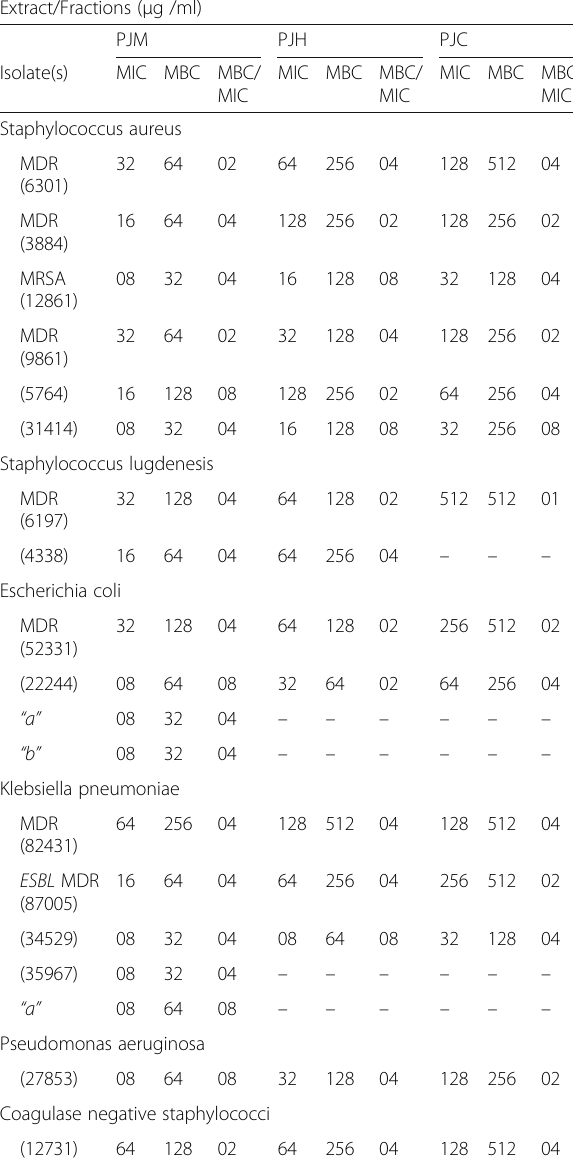
Table 5 MIC and MBC of P. jacquemontiana extracts against gram positive and gram negative